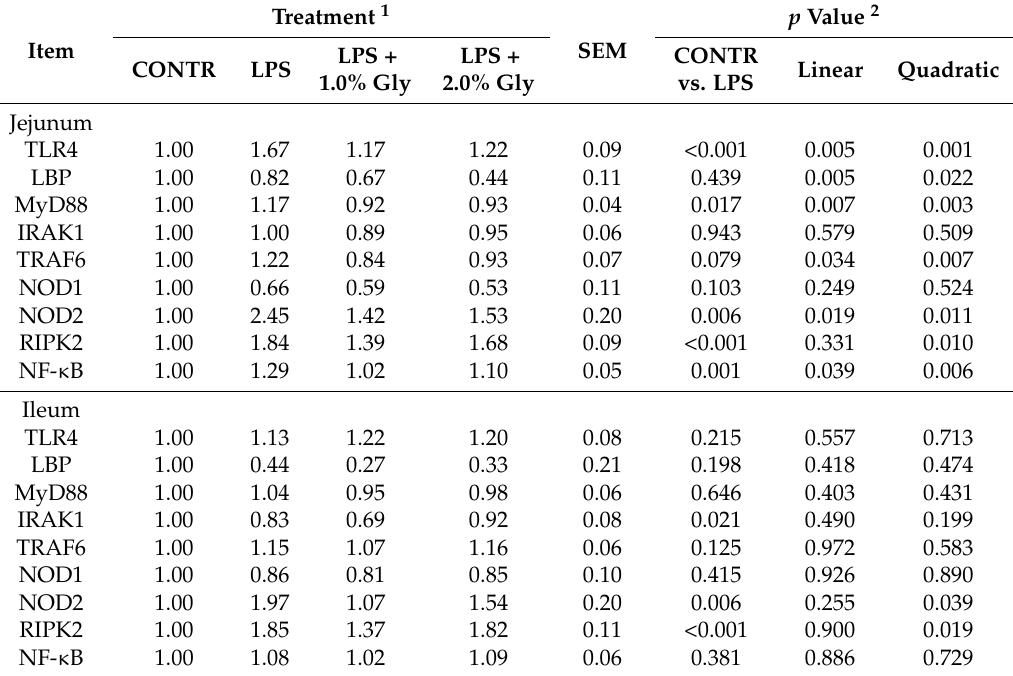
Table 5. Effect of glycine supplementation on intestinal mRNA expression of TLR4 and NOD and their downstream signals after 4 h LPS challenge in piglets.